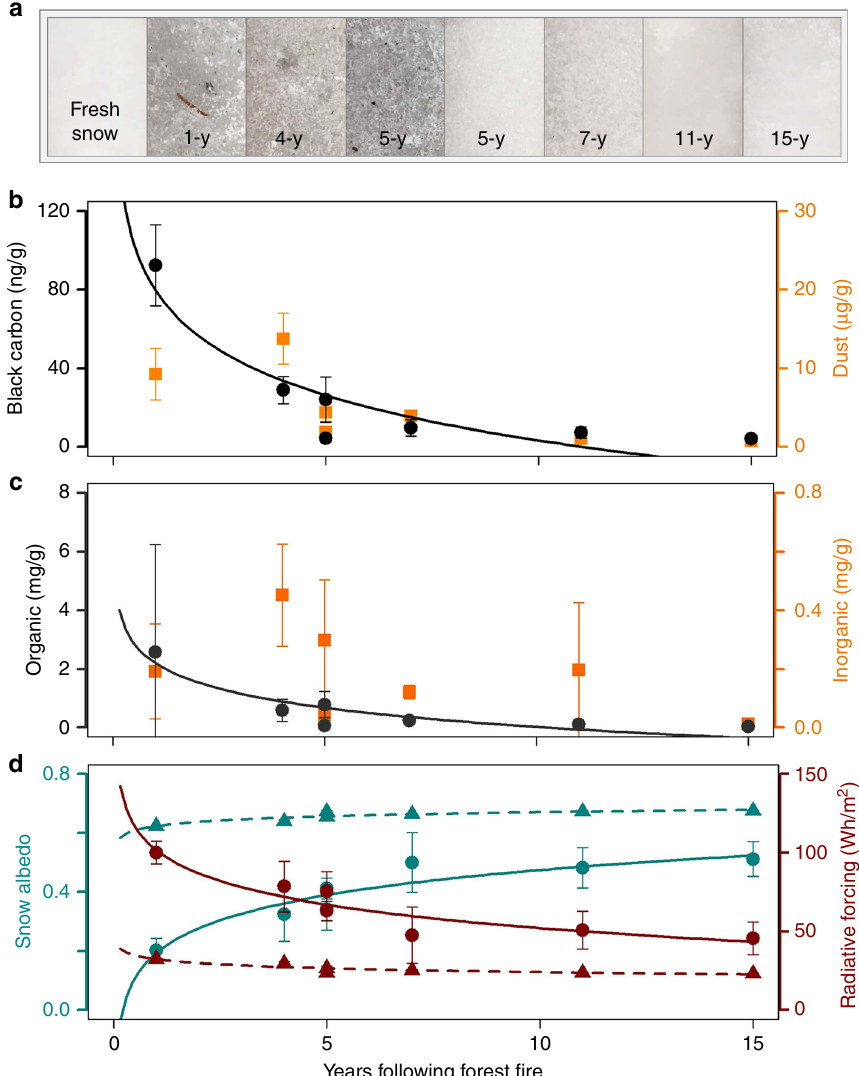
Fig. 3 Changing impacts of light absorbing impurities (LAI) on snow following fi re based on 2017 sampling of chronosequence of western burned forests (Fig. 1). a Photographs of snow-surface samples. b Black carbon and dust concentrations. c Organic and inorganic debris concentrations. d Measured (dark cyan dots and solid line) and SNICAR-modeled (dark cyan triangles and dashed line) snow albedo, with associated 15 January hourly, average, post- fi re radiative forcing on snow for measured (dark red dots and solid line) and SNICAR-modeled (dark red triangles and dashed line) albedo values. Error bars indicate one standard